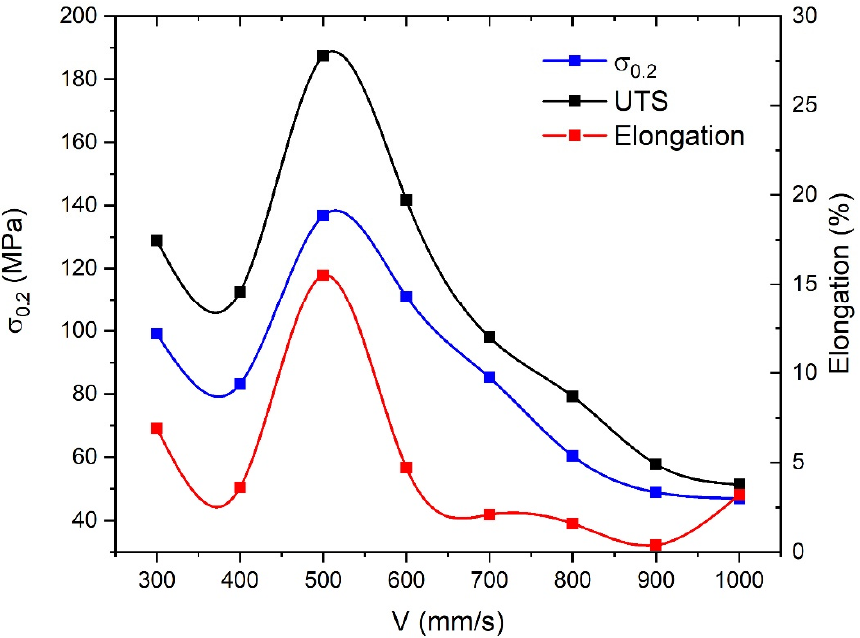
Figure 5. Dependences of ultimate tensile strength and yield strength on scanning speed.